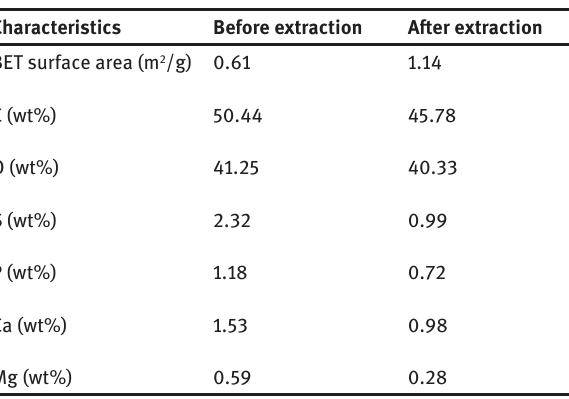
Table 1: Some characteristics of mustard biomass before and after oil extraction. Characteristics